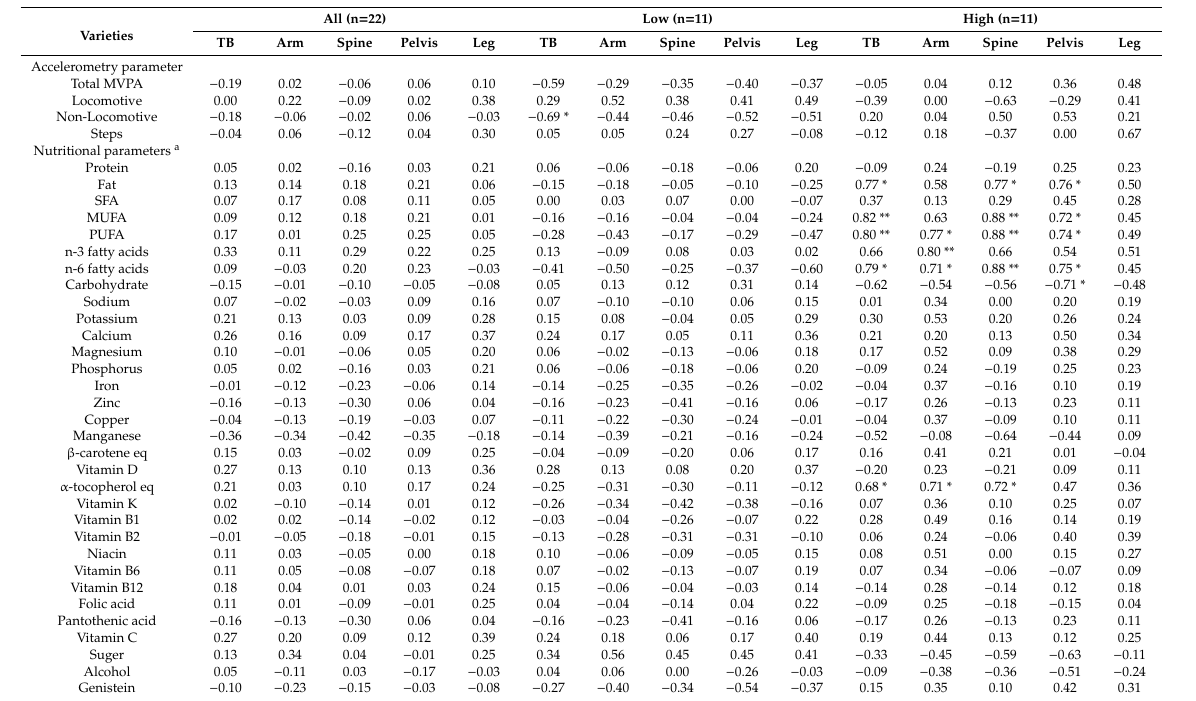
Table 5. Partial correlation coe ffi cients adjusted for age and BMI between physical activity, nutritional parameters and bone mineral